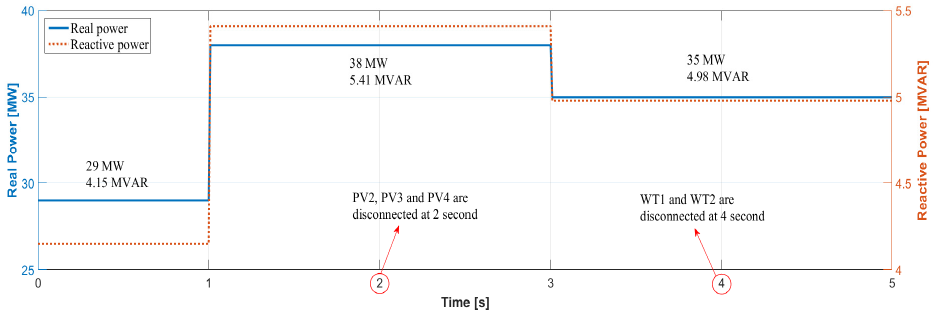
Figure 13. Total load changes of the “Y” substation.